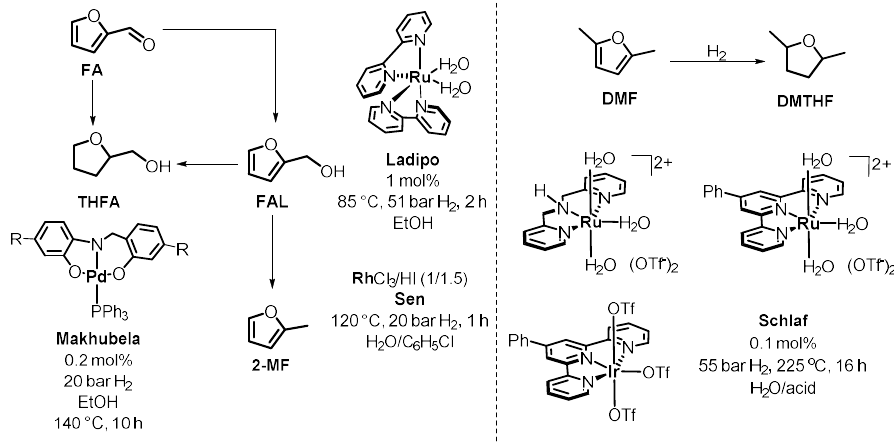
Figure 7. Catalytic HDO of HMF and catalyzed by transition metal complexes.